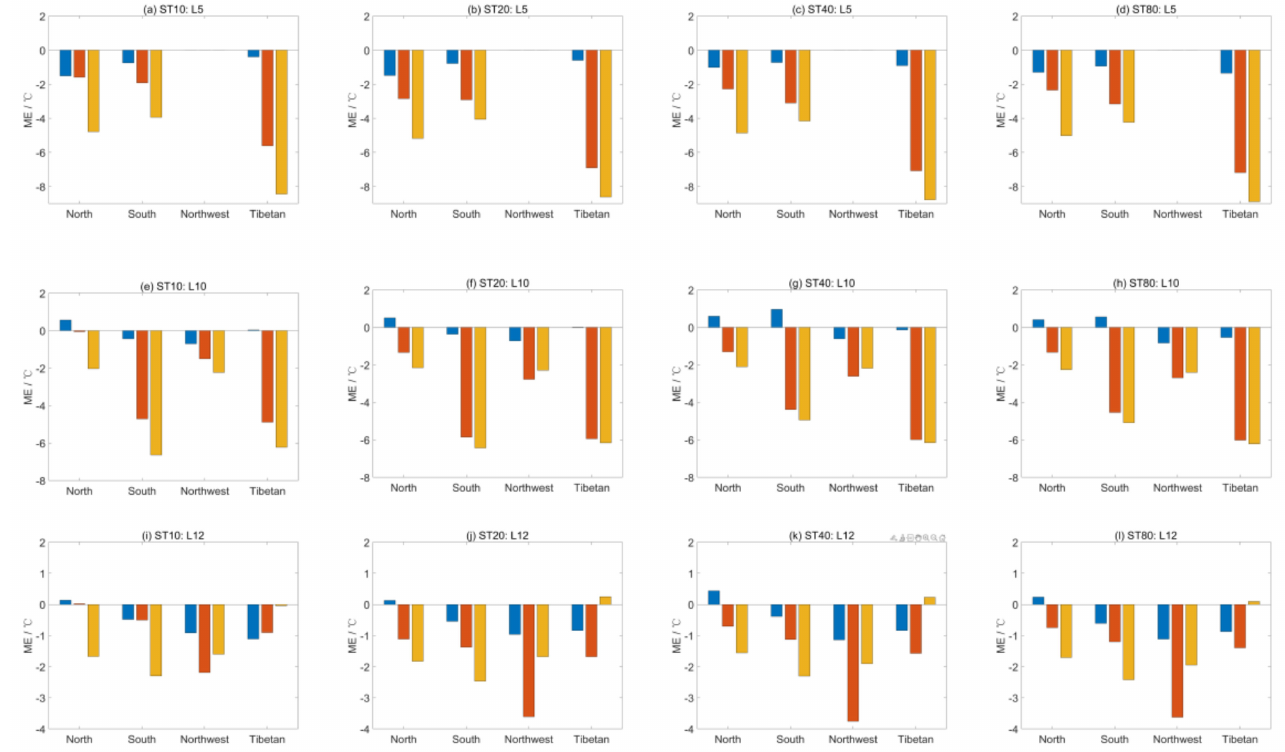
Figure 12. ME of soil temperature in different regions of mixed forests, grasslands, and croplands. ( a – d ) are for mixed forests, ( d – g ) are for grasslands, and ( i – l ) are for